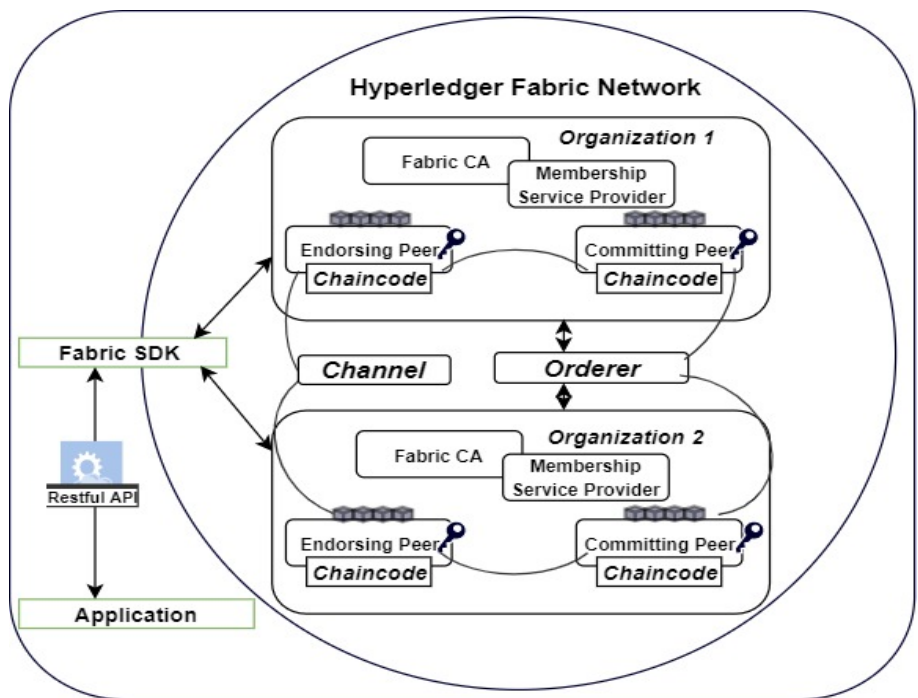
Figure 3. Hyperledger Fabric Blockchain Network.